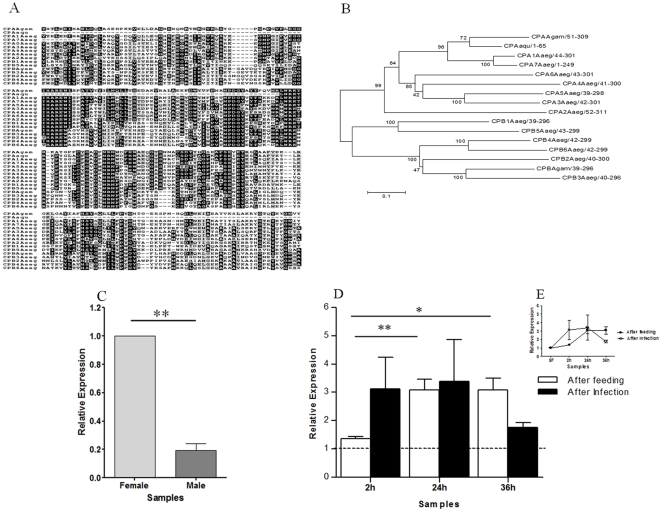
Characterization of carboxypeptidase induction in mosquitoes fed on sugar, blood, or infected blood.A: Multiple aminoacid sequence alignment of A. aquasalis and A. gambiae carboxypeptidases. B: Phylogenetic tree constructed using neighbor-joining method. C–E: Expression levels of carboxypeptidase determined by RTPCR following various feeding regimens. C: Sugar-fed males and females, D and E: sugar-fed (dotted line and SF), blood-fed (AF) and P. vivax infected (AI) females. h–hours. Accession numbers of carboxypeptidase sequences from: A. aquasalis (Aaqu) (CP–consensus of GR486815 and GR486794); A. gambiae (Agam) (CPA - AGAP009593 and CPB-CAF28572.1); and A. aegypti (CPA1-AAD47827.1, CPA2-AAT36726.1, CPA3-AAT36727.1, CPA4-AAT36728.1, CPA5-AAT36729.1, CPA6-AAT36730.1, CPA7-AAT36731.1, CPB1-AAT36735.1, CPB2-AAT36733.1, CPB3-AAT36734.1, CPB4-ABO21075.1, CPB5-ABO21076.1, and CPPB6-ABO21077.1). +−: s.e.m.; * p<0.05, ** 0.03>p>0.01, *** p<0.01.